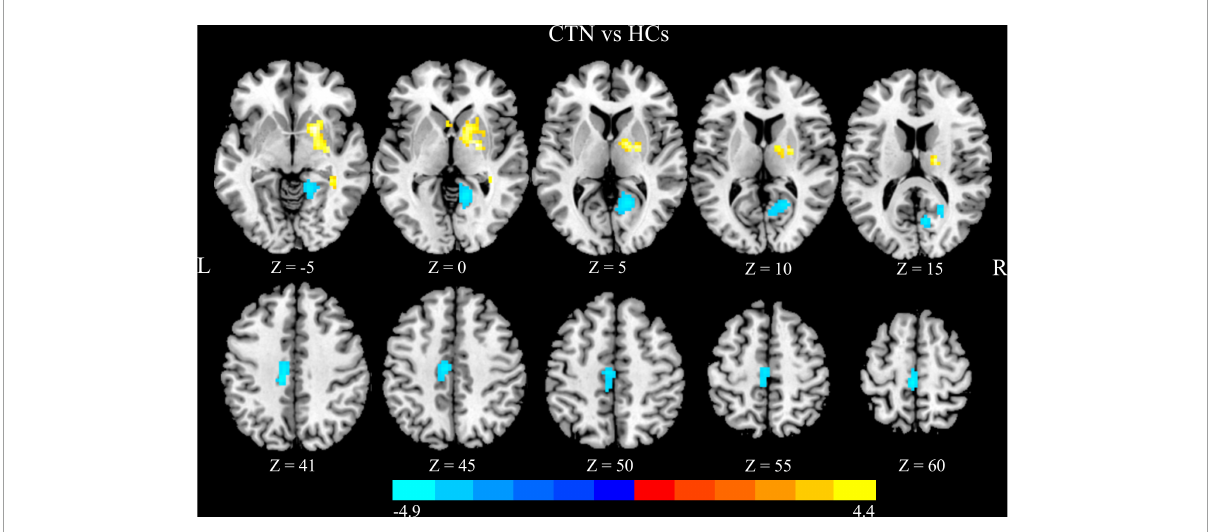
FIGURE1 Altered DC in CTN patients. Compared with HCs, the patients with CTN showed greater DC values in the right pallidum and right putamen, and lower DC values in the right lingual gyrus, right calcarine sulcus, left paracentral lobule, and left midcingulate cortex ( p < 0.05, FDR corrected). The warm colors indicate a higher DC value whereas the cooler colors indicate a lower DC value. The color bar indicates T -value. DC, degree centrality; CTN, classic trigeminal neuralgia; HCs, healthy control subjects; FDR, false discovery rate.